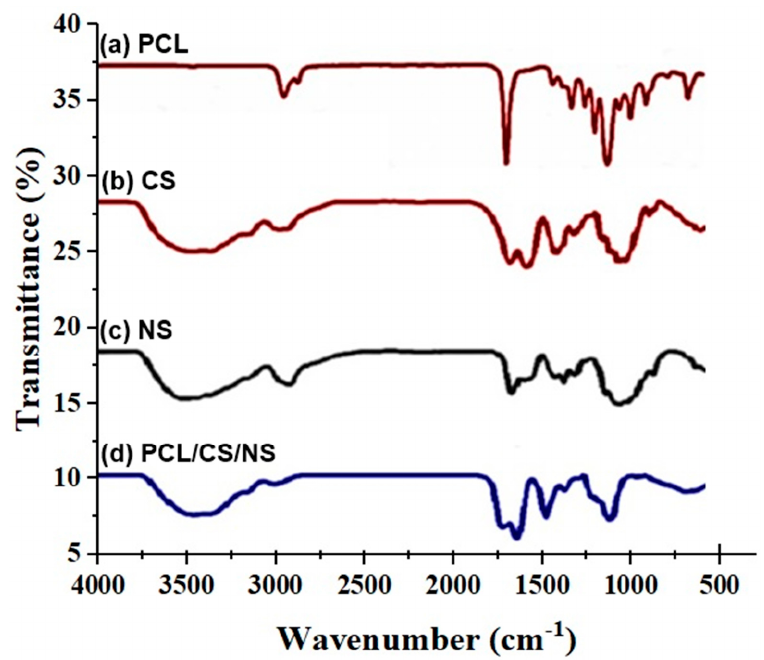
Figure 3. FTIR spectrum of PCL/CS/NS, PCL, CS, and NS Figure 3 FTIR spectrum of PCL/CS/NS, PCL, CS, and NS extract.